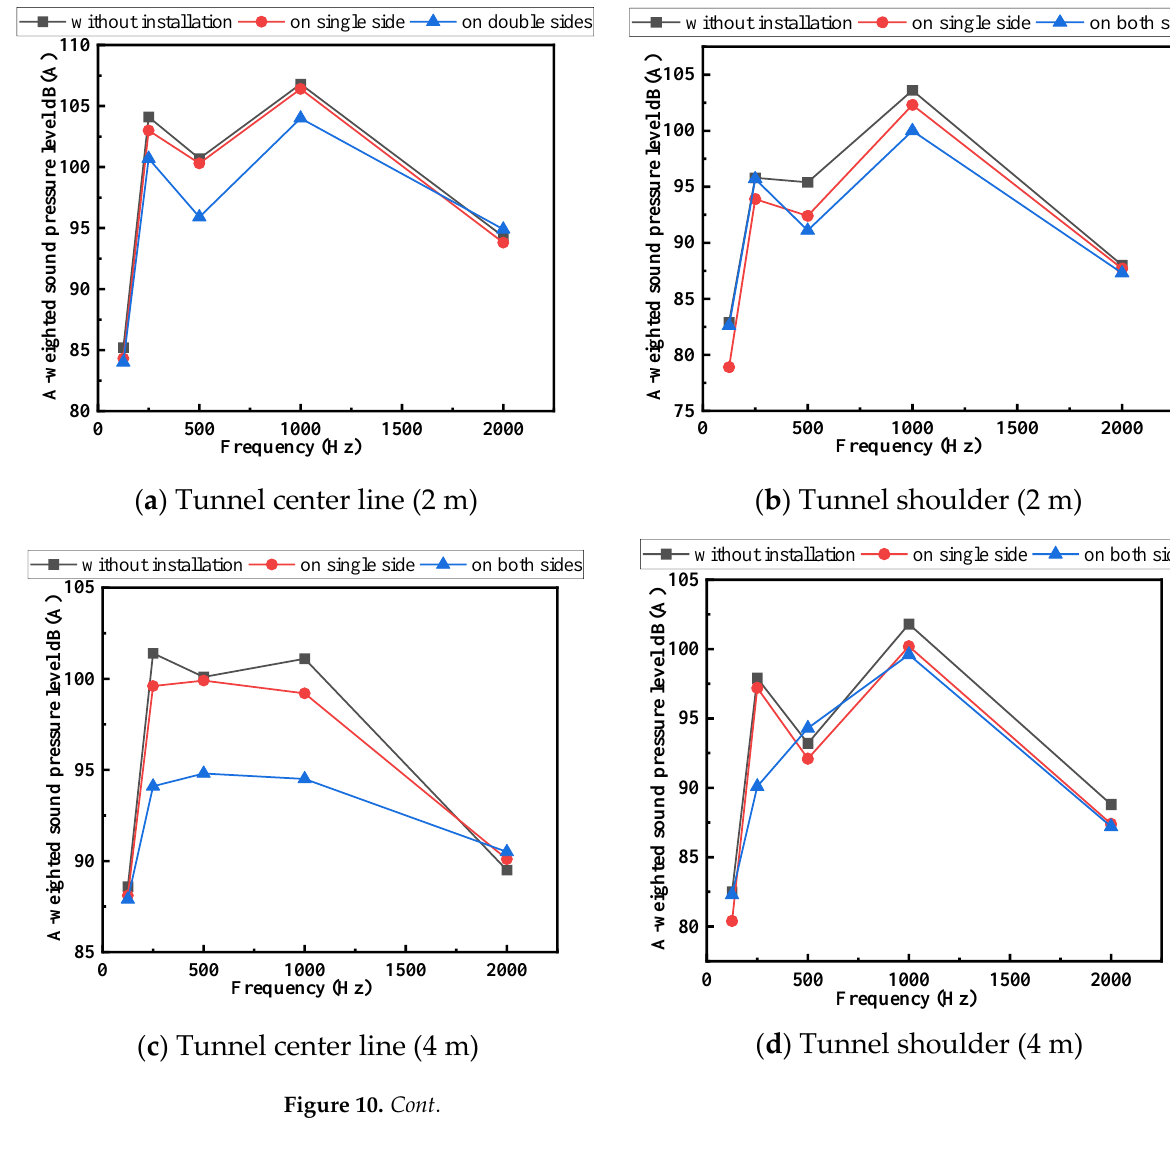
( f ) Tunnel shoulder (6 m) Figure 10. Influence of frequency. 4.2. Test Results of Car Noise in the Tunnel Case II mainly studies the sound absorption performance of closed-cell aluminum foam under moving sound sources. Analysis of the measurement results in Case II can more accurately reveal the noise reduction effect of closed-cell aluminum foam boards on vehicle noise in tunnels. Since the impact of the vehicle model on the noise generated was considered in the test, when analyzing the possible noise reduction effect of closed-cell aluminum foam in tunnel applications, the analysis was carried out according to the three common vehicle models in the tunnel, as shown in Figure 11a – c. It can be seen from the above that each point in the figure is the representative value of the average of 10 test data. It can be seen from the figure that when the aluminum foam board is not installed, the noise generated by the large car in the tunnel is the largest, and the maximum instantaneous A-weighted sound pressure level reaches 95.1 dB(A). The sound pressure level of noise produced by small cars is slightly lower than that of mid- sized cars, at 87.7 dB(A) and 88.5 dB(A) respectively. After the single-sided aluminum foam boards were installed, the noise generated by small and middle-sized cars is de- creased to a limited extent. The maximum instantaneous A-weighted sound pressure level in the tunnel when a bicycle passes through the tunnel is reduced by less than 2 dB(A). However, the single-sided aluminum foam board has a more obvious reduction effect on the traffic noise generated by large vehicles, which is reduced by 3.4 dB(A). The attenua- tion of the vehicle noise by the double-sided aluminum foam boards is greater than the vehicle noise when installed on single side or not installed. After installation on both sides, the noise attenuation for medium-sized cars is the strongest, reaching 4.9 dB(A). The